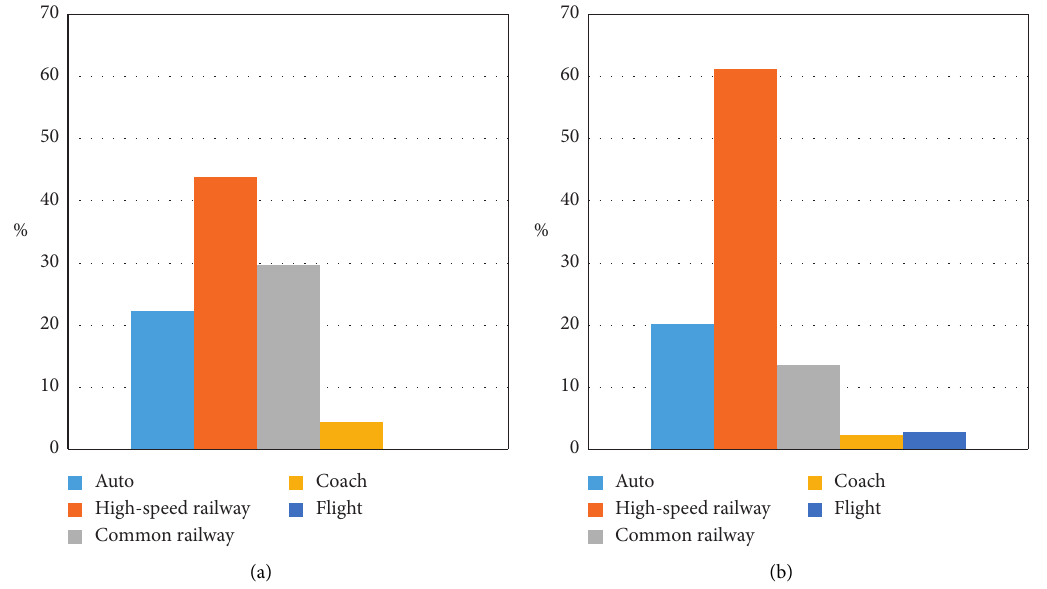
Figure 5: Aggregated mode flow distribution ratio of destination regions: (a) inside Hubei and (b) outside Hubei. Table 13: Results of the aggregated traffic flow ratio of cities inside Hubei under cases applying lockdown on different travel modes. Original case (%)